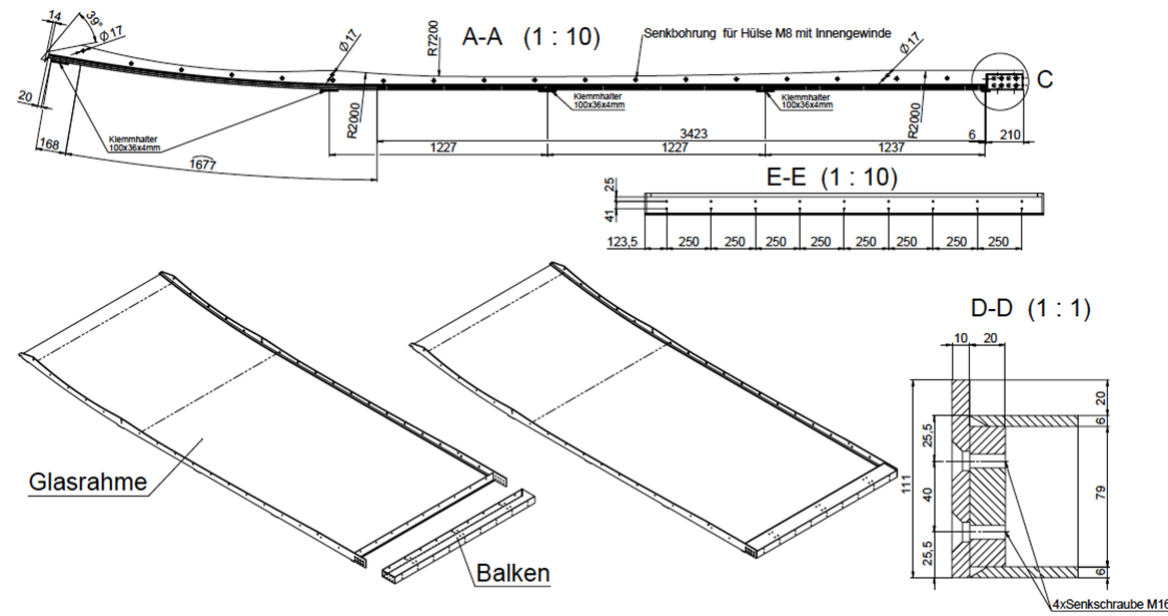
Fig. 6 Steel-glass frame.